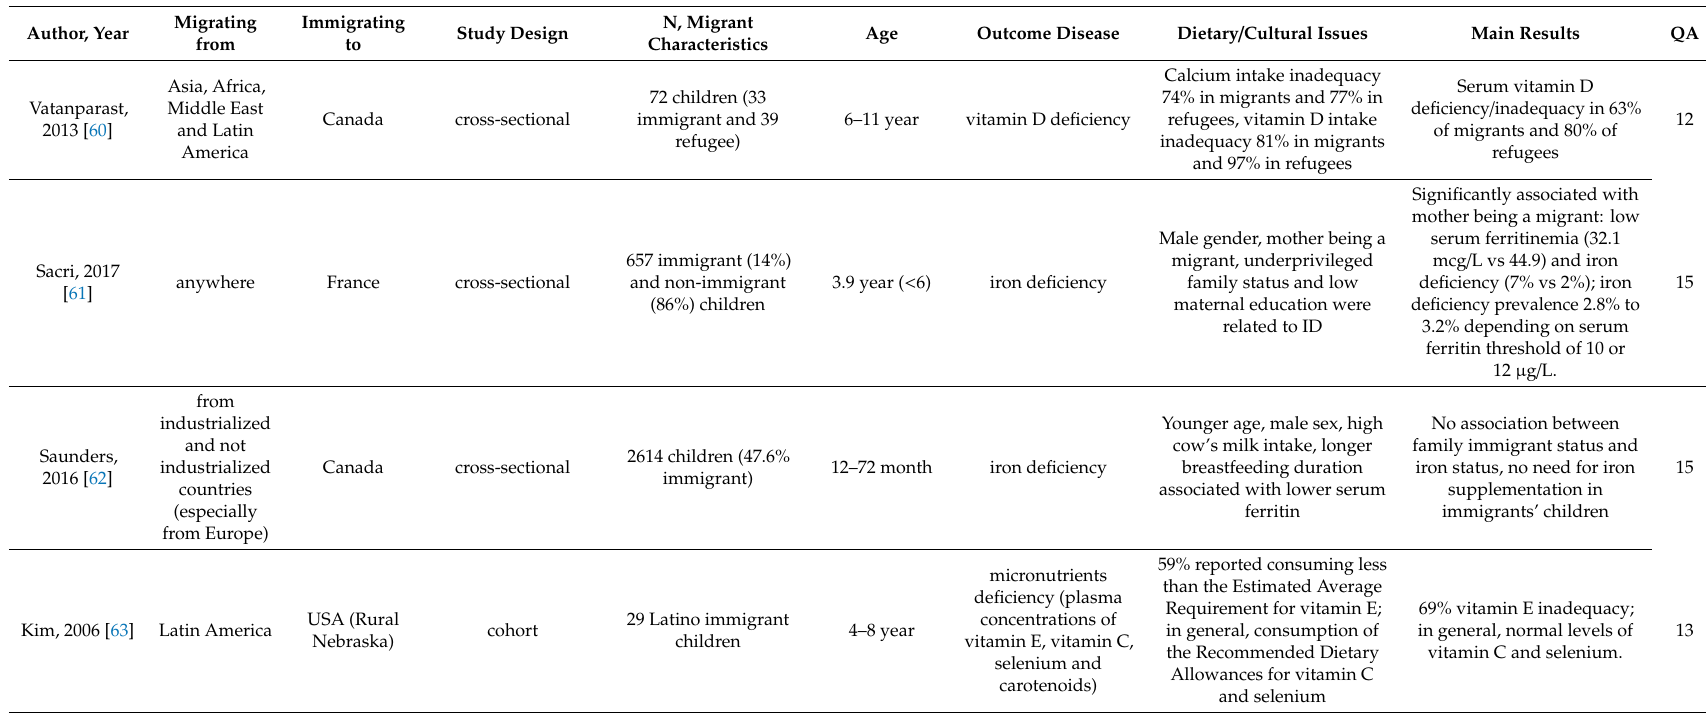
Table 7. Characteristics and main results of the included studies.